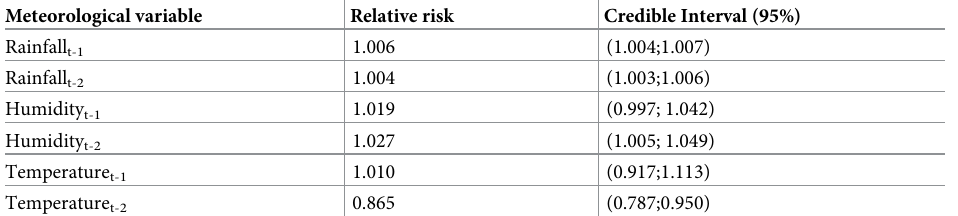
Table 2. Estimated changes in risk of leptospirosis, Salvador, Brazil, 1996–2010. Each row gives the estimate of the relative risk associated with a unit change in the corresponding meteorological variable and the associated 95% Bayes- ian credible